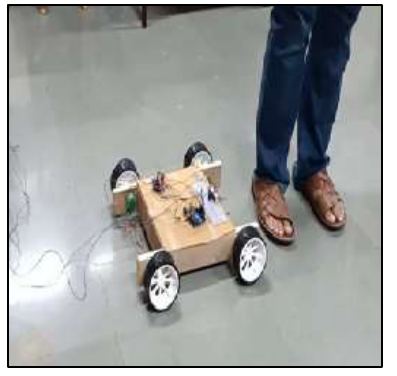
Fig. 16. Obstacle Avoiding Bot Test Run 2 with Obstacle (Human)